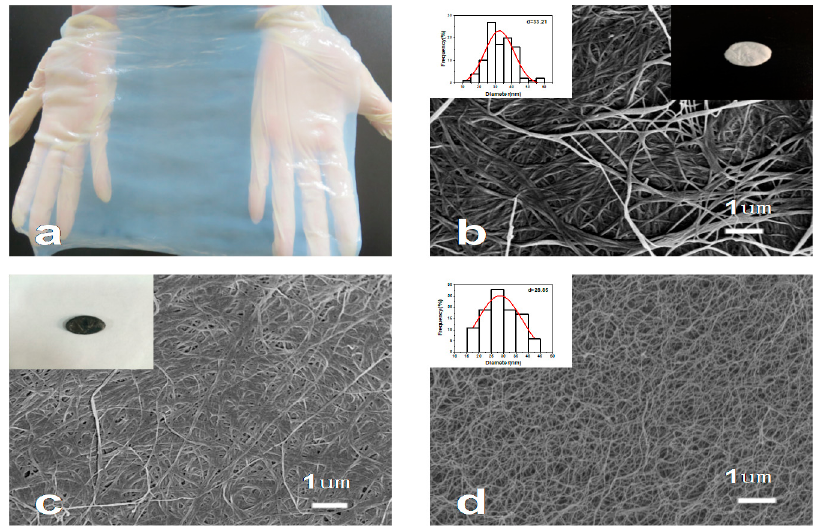
Figure 1. ( a ) Photograph of a bacterial cellulose (BC) pellicle. ( b ) SEM image of the freeze-dried BC pellicle surface (Top right inset: the typical sample, d = 20 mm; Top left inset: the fiber diameter distribution). ( c ) SEM image of the pyrolyzed (P)BC surface (inset: the typical sample, d = 16 mm). ( d ) SEM image of the inner of PBC (inset: the fiber diameter distribution).